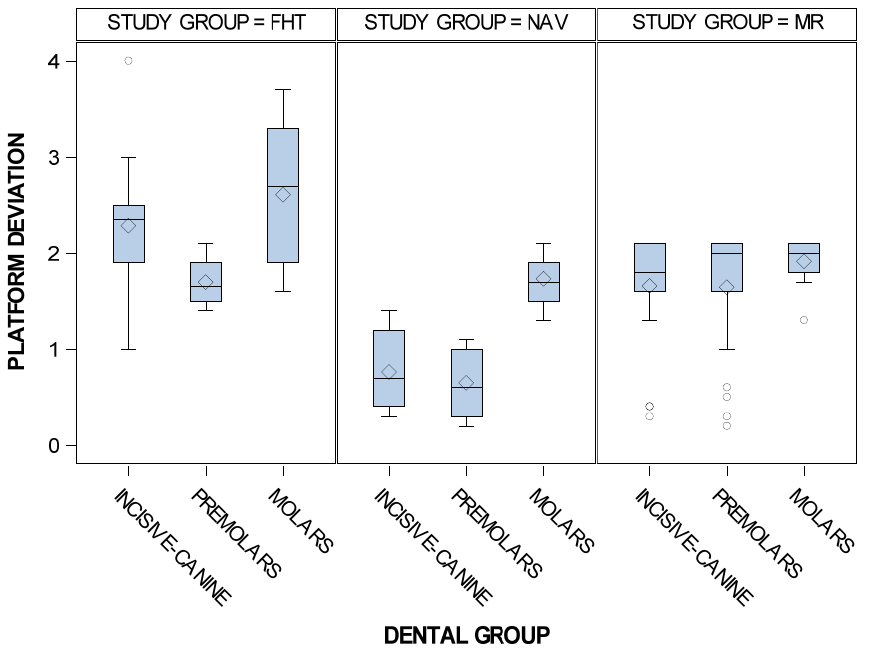
Figure 6. Box plot of the coronal entry-point deviations of the orthodontic micro-screws placed using the computer-aided static navigation technique, mixed reality technique and conventional freehand technique in the incisive-canine, premolar and molar dental sectors. Table 3. Descriptive deviation values at coronal entry-point (mm) of the orthodontic micro-screws placed in the selected tooth